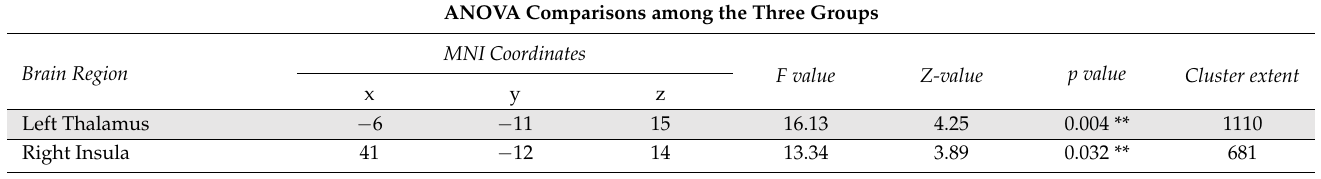
Table 4. Structural covariance analysis. Seed region: Right Caudate.